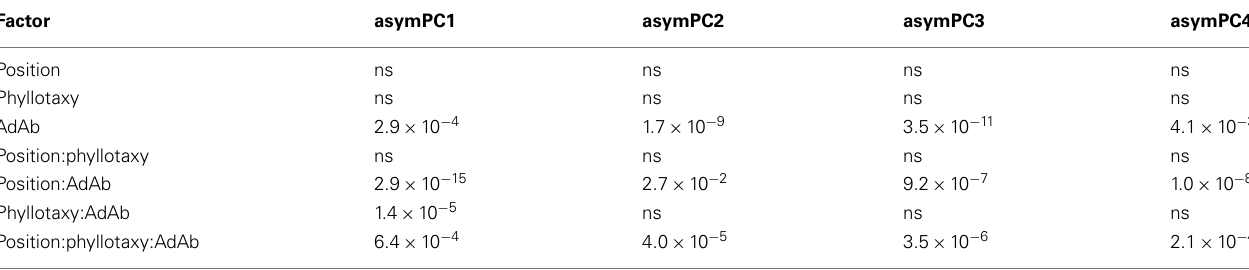
Table 1 |ANOVA results for leaf area and PCs explaining asymmetric